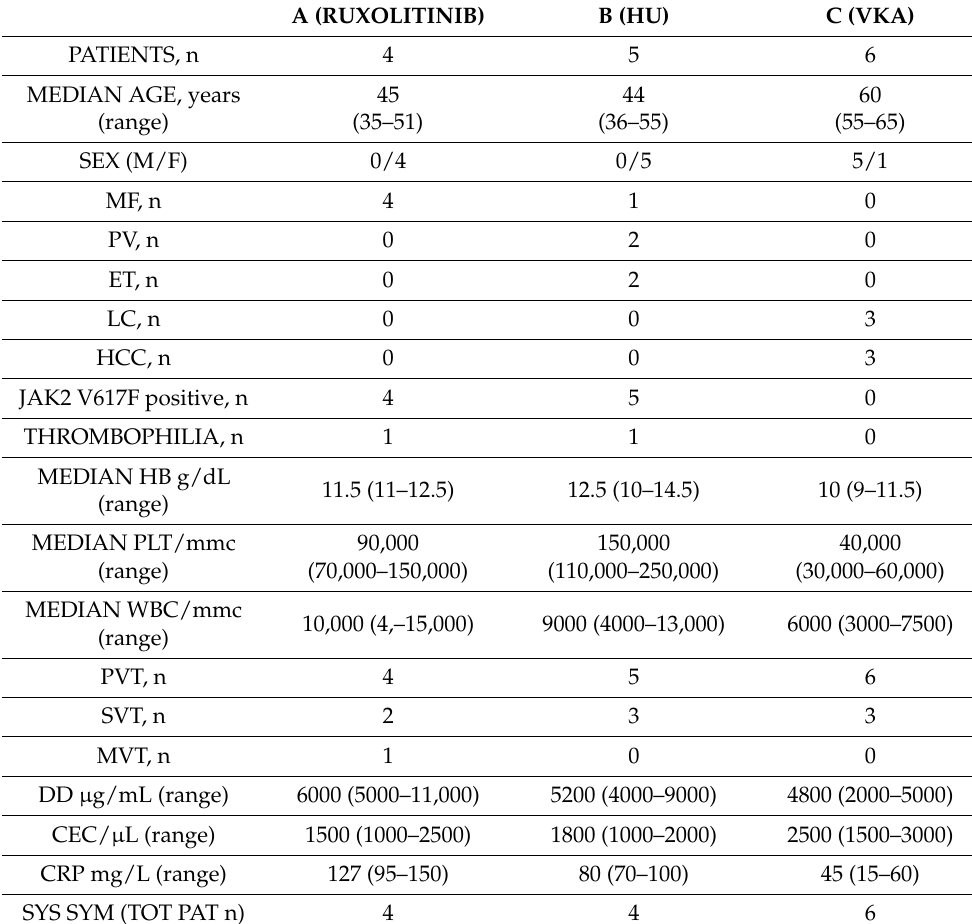
Table 1. Patient characteristics at SVT